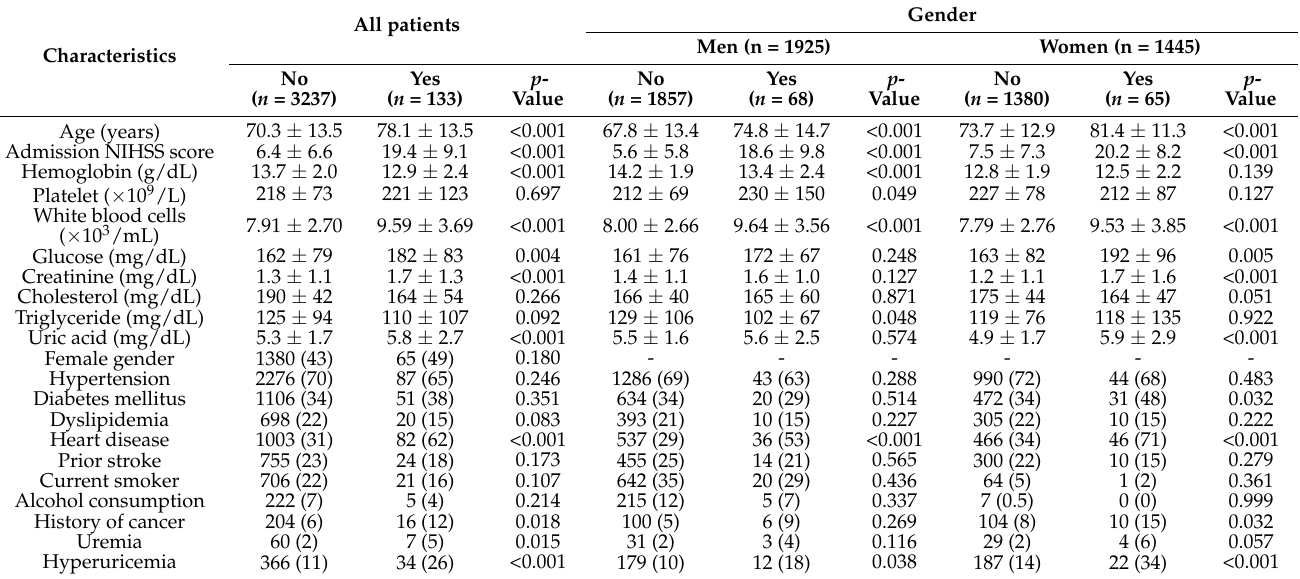
Table 3. Univariate analysis of factors related to death in 3370 patients with acute ischemic stroke.